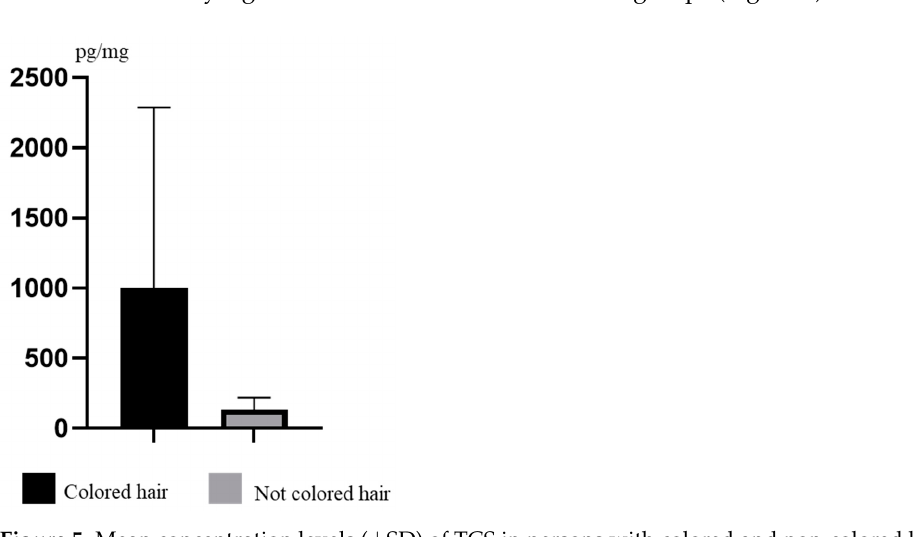
Figure 4. Mean concentration levels (±SD) of TCS in persons at the age of 22–35 and 45–67.